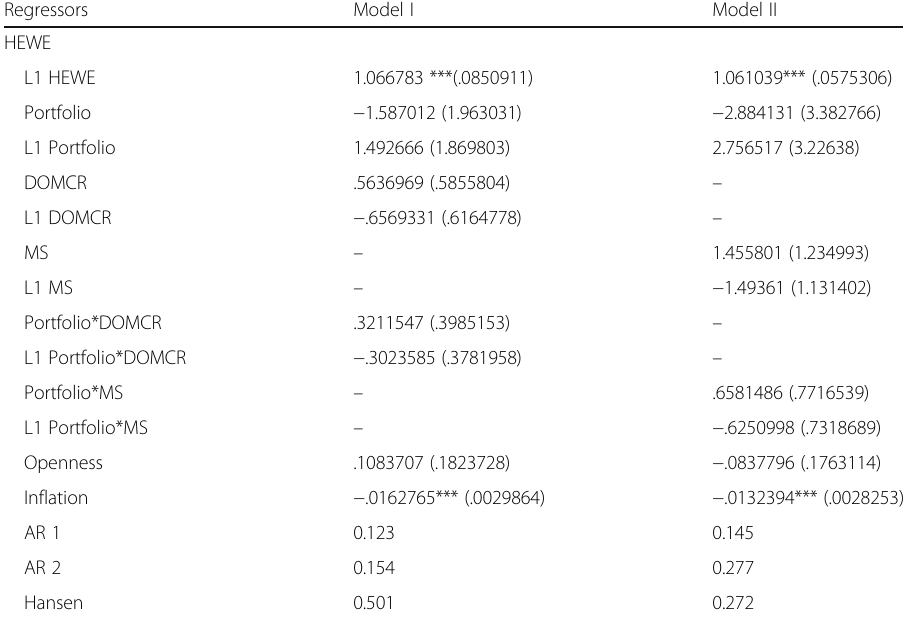
Table 12 Dynamic panel data estimation, one-step system GMM: interaction effect of Portfolio in- flow and financial development on